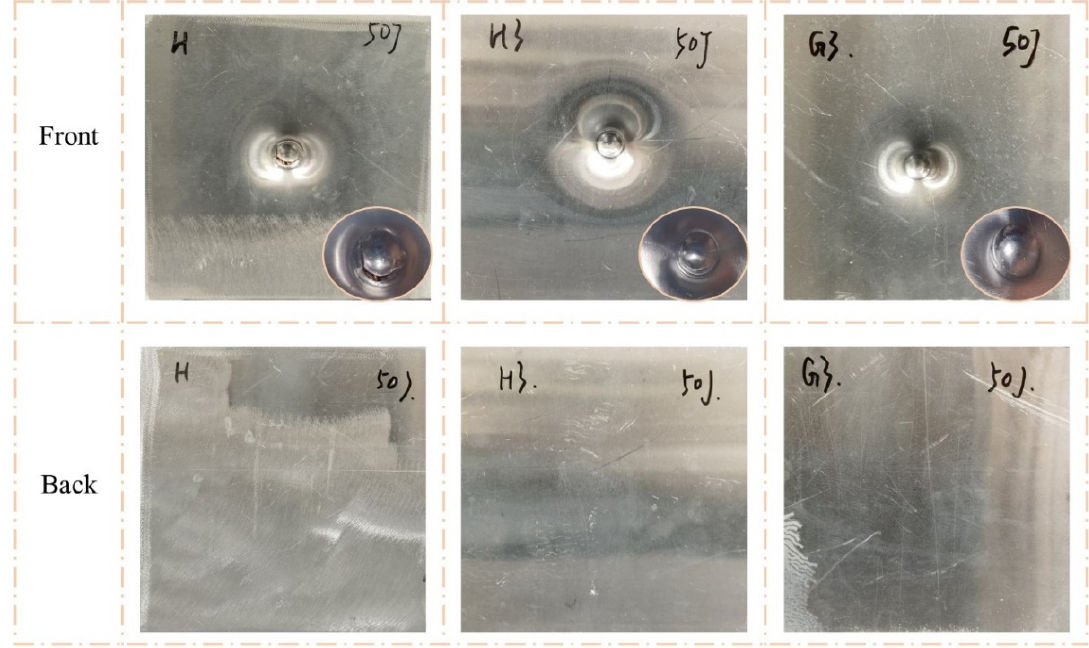
Figure 7. Damage modes of H, H3, and G3 under 50 J impact energy with hemisphere impactor.